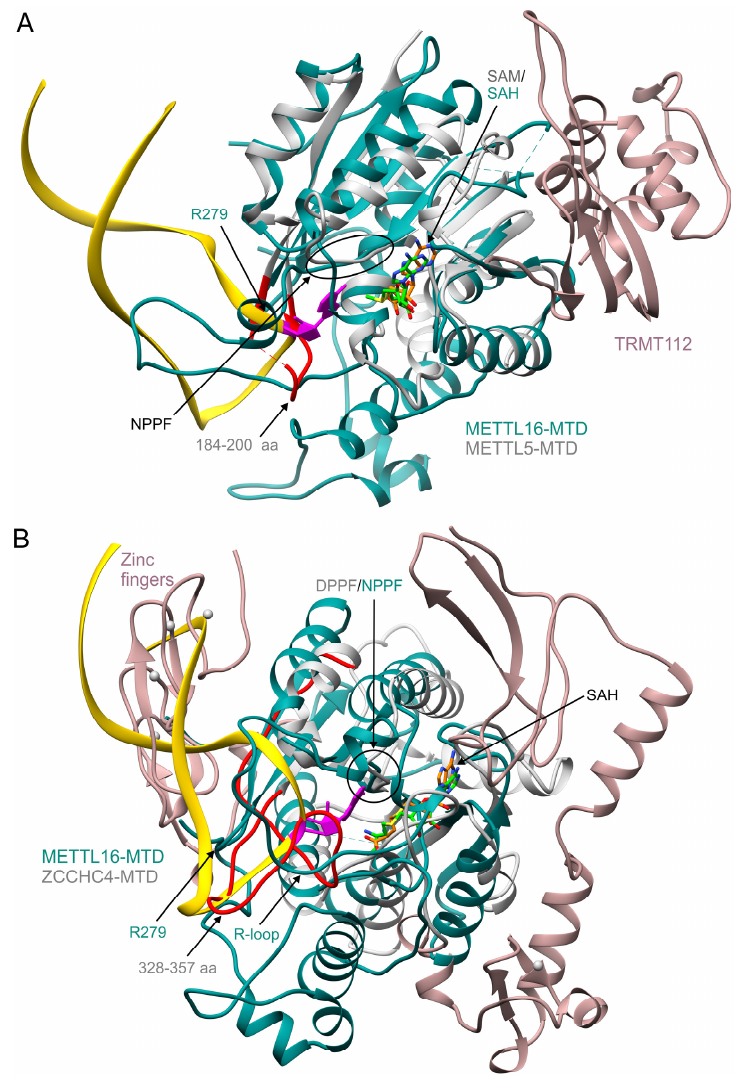
Figure 4. Structural comparison between the MTD domain of METTL16 and the MTDs of human rRNA m 6 A MTases. All structural elements are color-coded as in Figure 3. Panels present superposi- tion of human METTL16-MTD/hp1x/SAH structure with ( A ) METTL5/TRMT112/SAM complex (6h2u); ( B ) ZCCHC4 /SAH structure